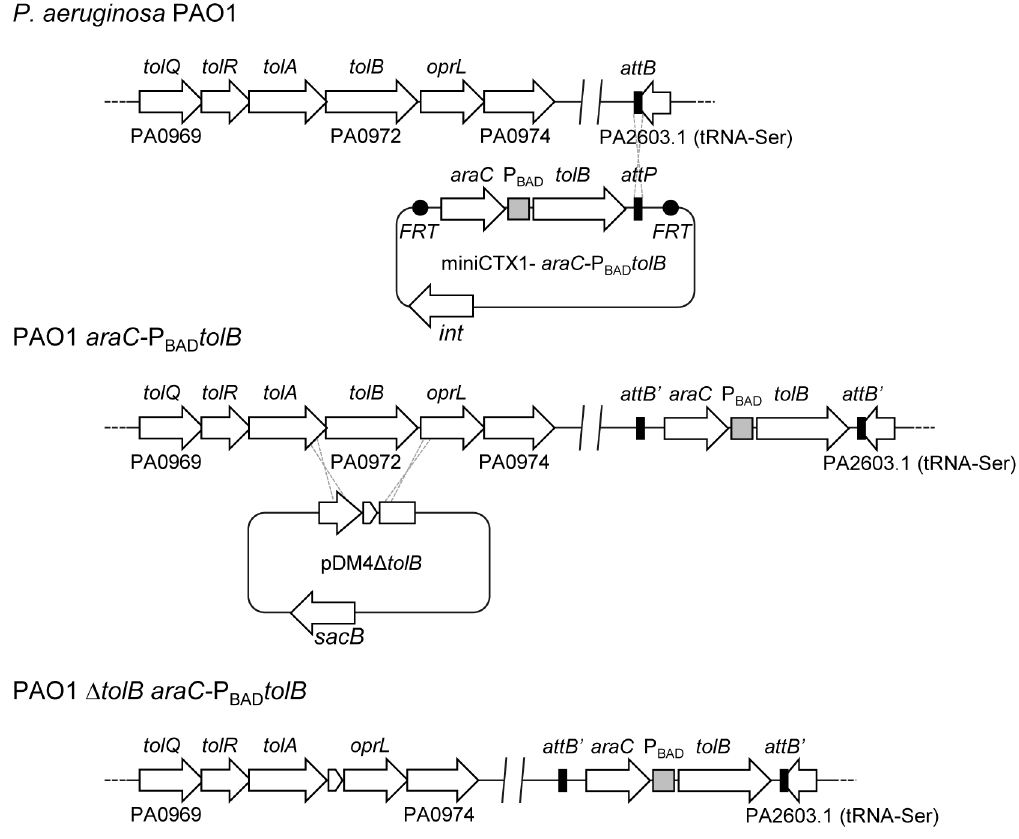
Figure 1. Scheme of the strategy used to generate the P.aeruginosa PAO1 tolB conditional mutant. An exogenous copy of the tolB coding sequence under the control of an arabinose-dependent promoter was inserted into the attB neutral site of the P. aeruginosa chromosome, by using the integration-proficient plasmid mini-CTX1- araC P BAD tolB (Table 1). After Flp-mediated removal of the mini-CTX1 backbone (not shown), the resulting strain (PAO1 araC P BAD tolB ) is a merodiploid for tolB . In-frame deletion of the endogenous copy of tolB was obtained using the suicide plasmid pDM4 D tolB (Table 1). Sucrose selection was carried out in the presence of arabinose to select removal of the pDM4 backbone, followed by PCR screening to identify clones carrying the tolB in-frame deletion. One of these clones was selected and used for the following analyses. This conditional mutant was named PAO1 D tolB araC P BAD tolB .